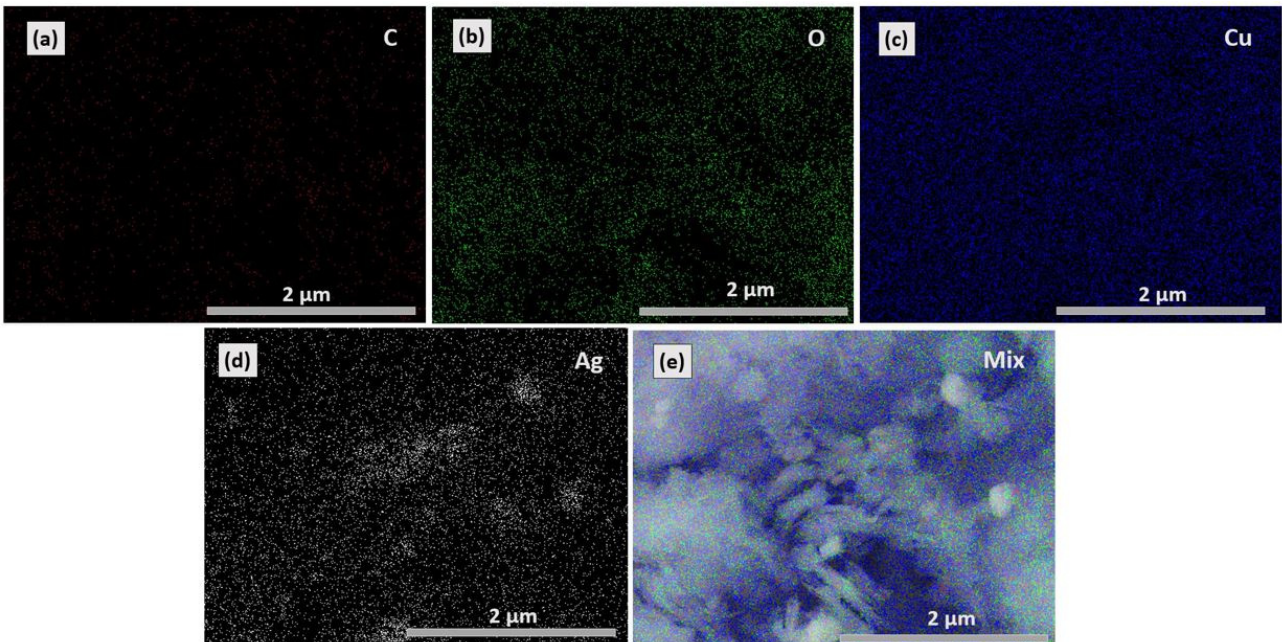
Figure 4. Elemental mapping of ( a ) C, ( b ) O, ( c ) Cu and ( d ) Ag content present in Ag-rGO@CuO nanocomposite. The Ag-